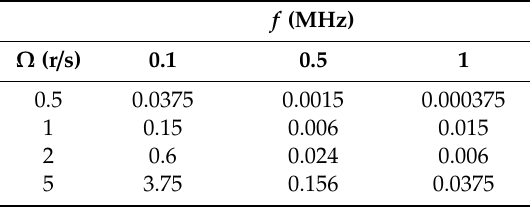
Table 2. The relative change of BAW propagation velocity ∆ V / V × 10 9